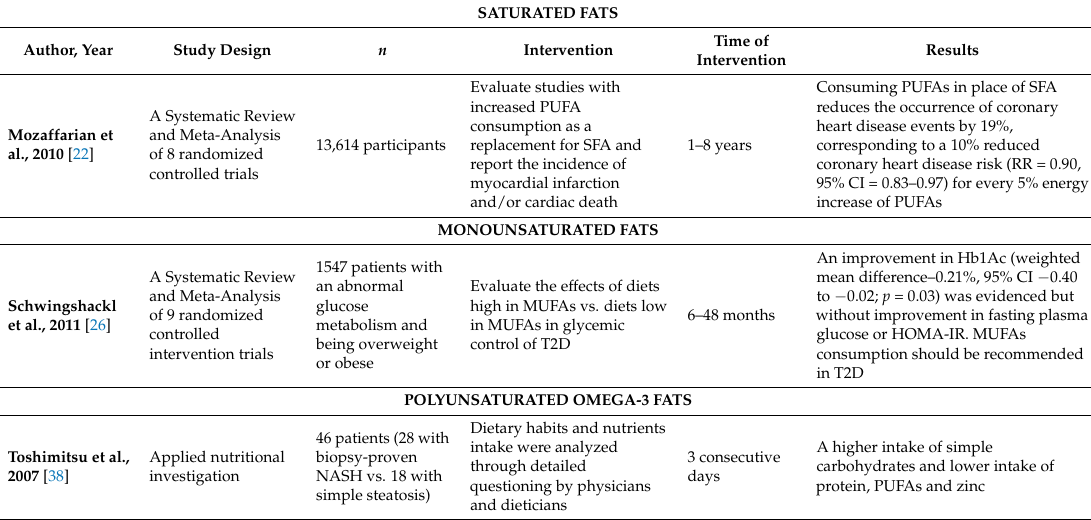
Table 3. The published systematic reviews, meta-analysis, human clinical trials and cross-sectional analysis using a liver biopsy to evaluate the effect of macronutrient composition in